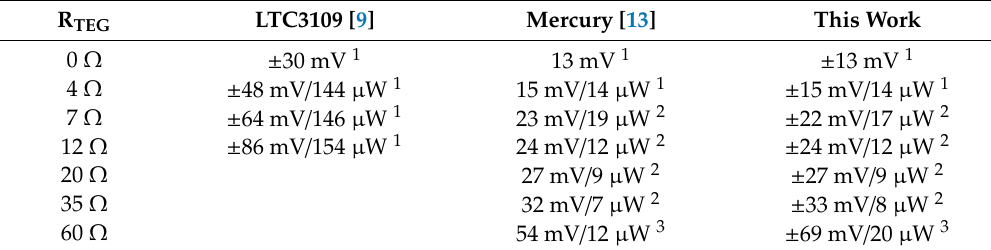
Table 1. Comparison of V OC and P MAX for cold start depending on R TEG